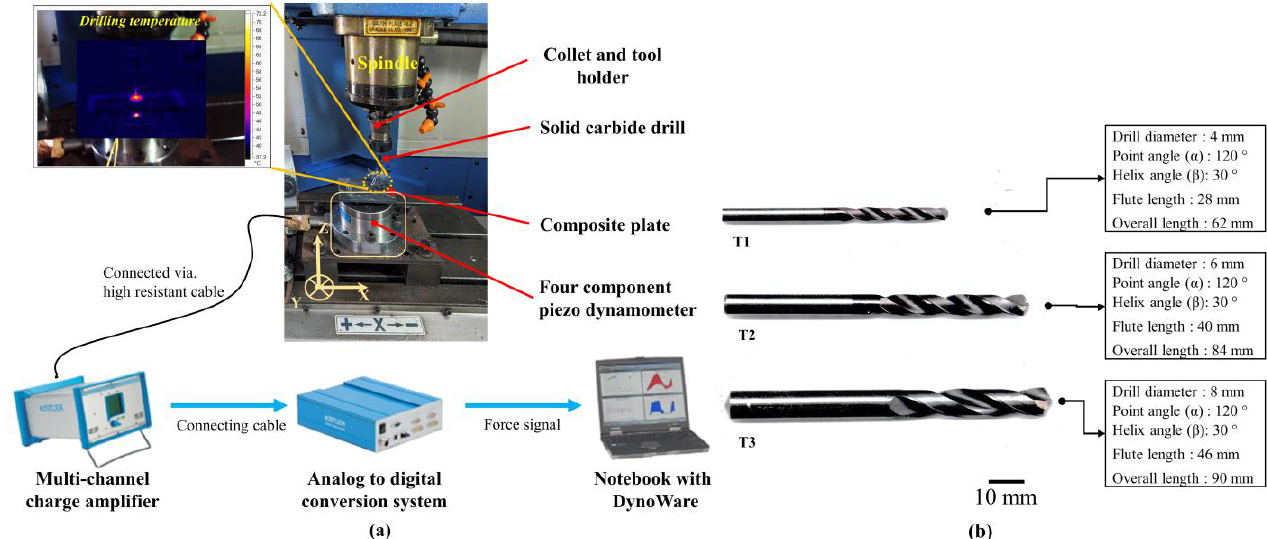
Figure 1. ( a ) CNC vertical machining setup with temperature and thrust force measurement and ( b ) photograph with details of solid carbide twist drills. ( b ) photograph with details of solid carbide twist Table 2. Input factors with levels.